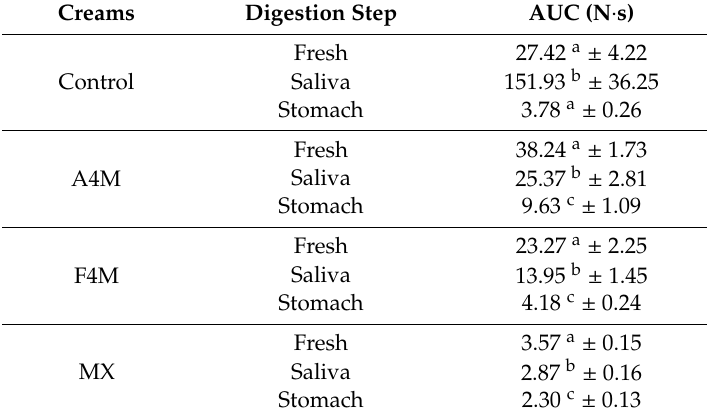
Table 2. Extrusion parameter (AUC) (mean ± standard deviation) of the fresh spreads and after in vitro digestion. Creams Digestion Step AUC (N · s)